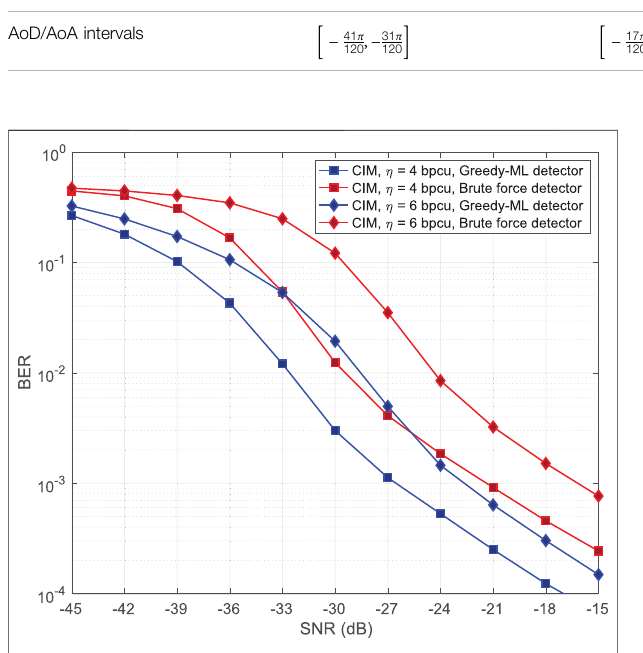
FIGURE 2 | BER performance for greedy-ML detector (1 bit CIM). FIGURE 3 | BER performance for analog architecture with greedy-ML